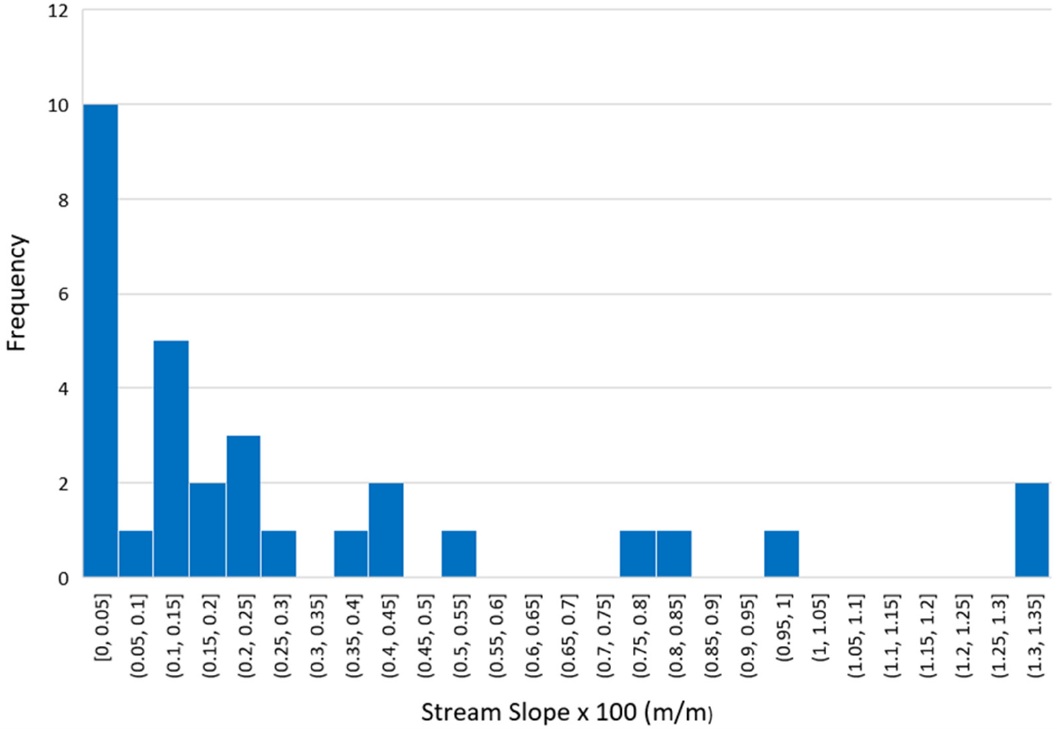
Figure 10. Stream slope at low head dams in Pennsylvania with fatalities recorded. Figure 12 shows the box and whisker plot for each distribution for Pennsylvania’s low head dams. The low head dams with fatalities dataset median is about 0.0015 m/m and low head dams without fatalities is about 0.0026